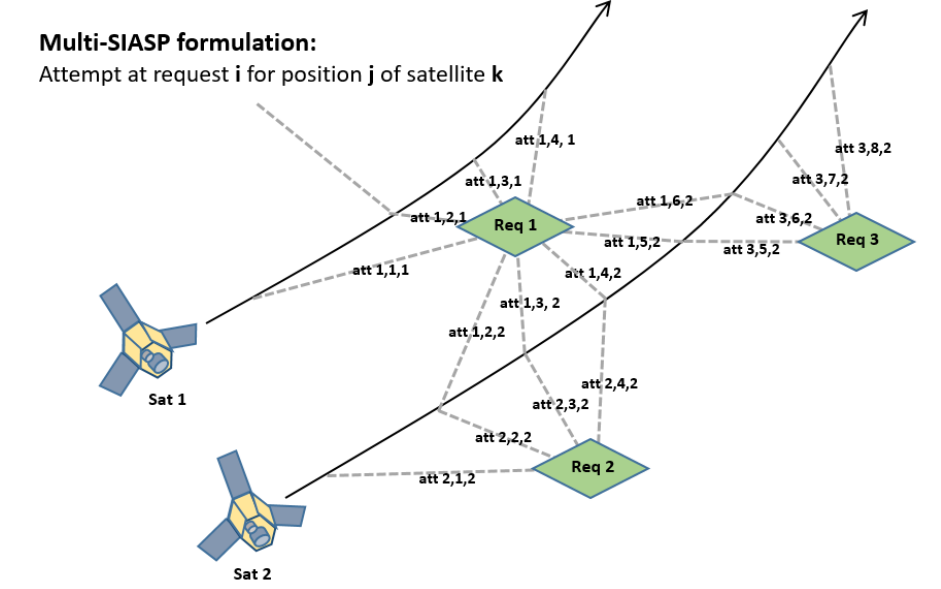
Figure 3. Holistic illustration of the decomposed scheduling problem and the utilized notation. Note that for a higher granularity, more satellite positions, and therefore more attempts, would be